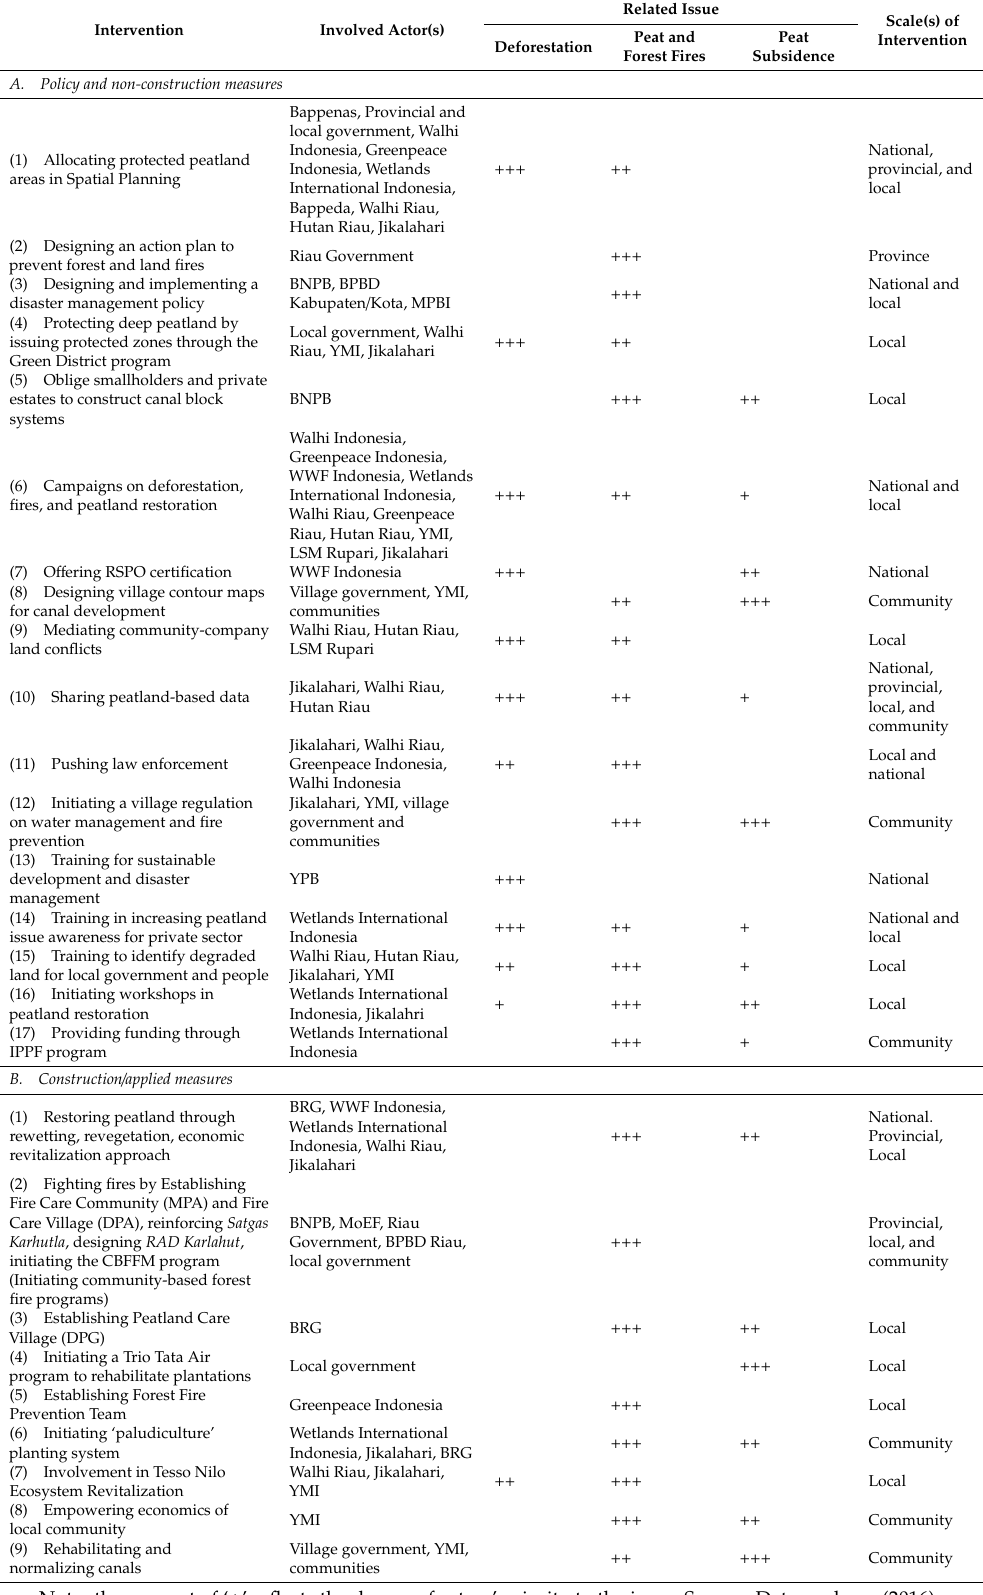
Table 2. Summary of interventions of the government, NGOs, and communities to deal with peatland problems in